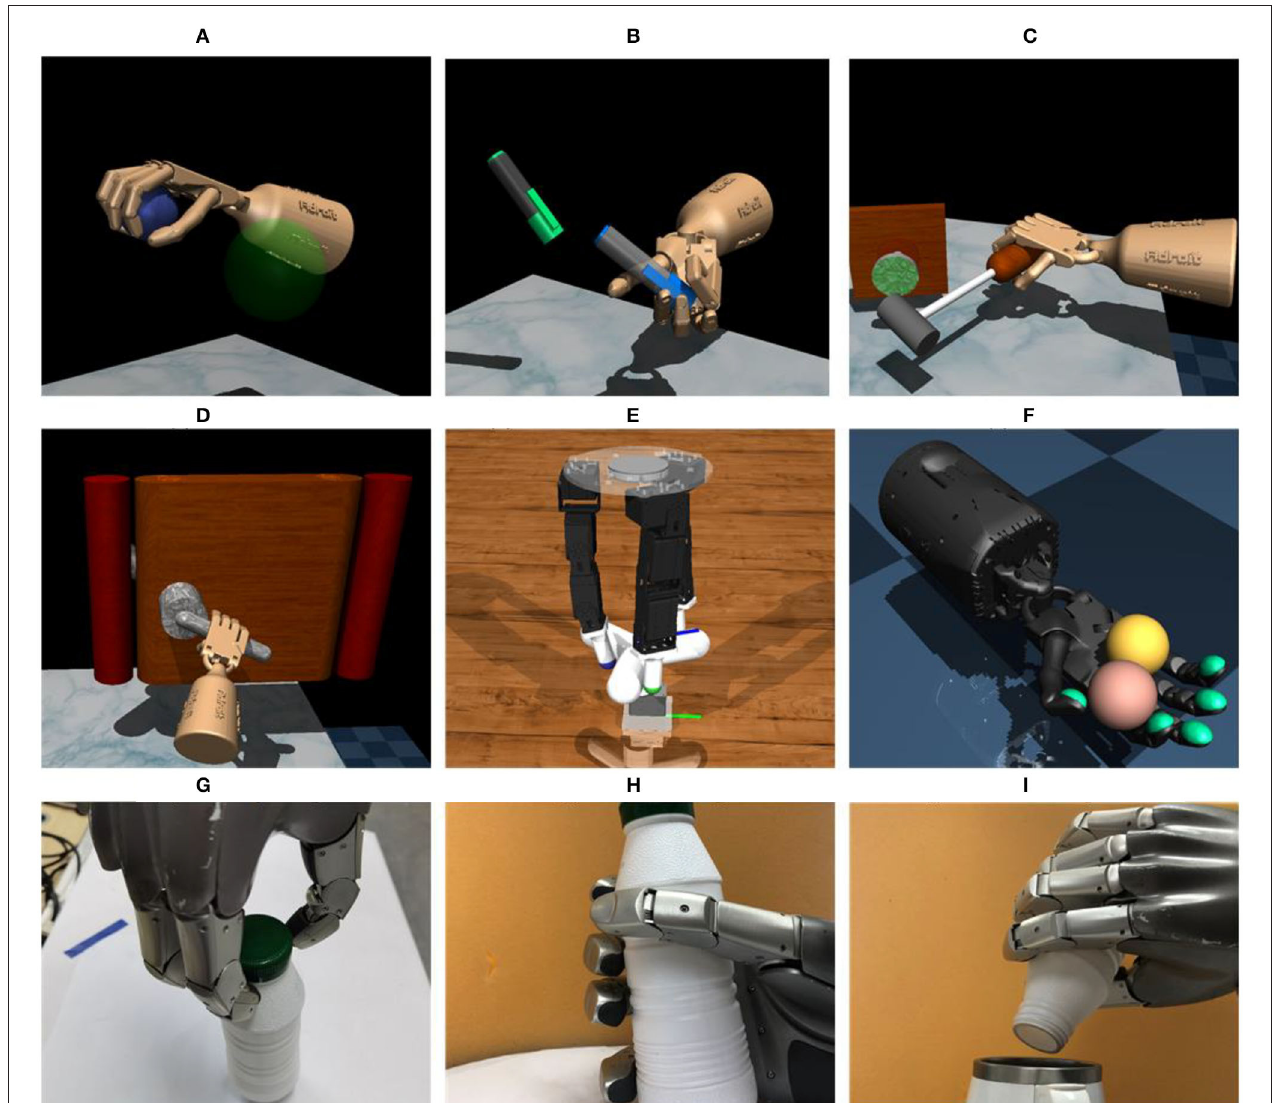
FIGURE 1 | Typical tasks of dexterous manipulation with a multi-fingered hand. (A) Relocation, (B) Reorientation & Relocation, (C) Tool use, (D) Door opening, (E) Valve turning, (F) In-hand manipulation, (G) Screwing, (H) Dexterous manipulation, and (I)